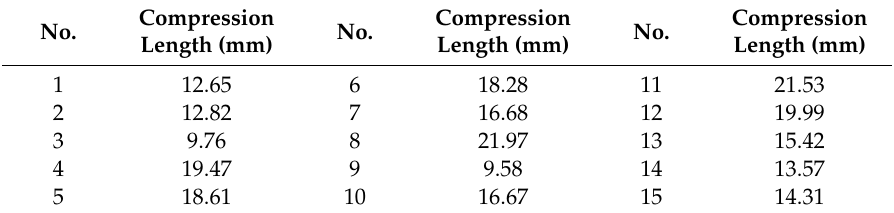
Table 2. Compression length of the energy absorbing cup in the firing